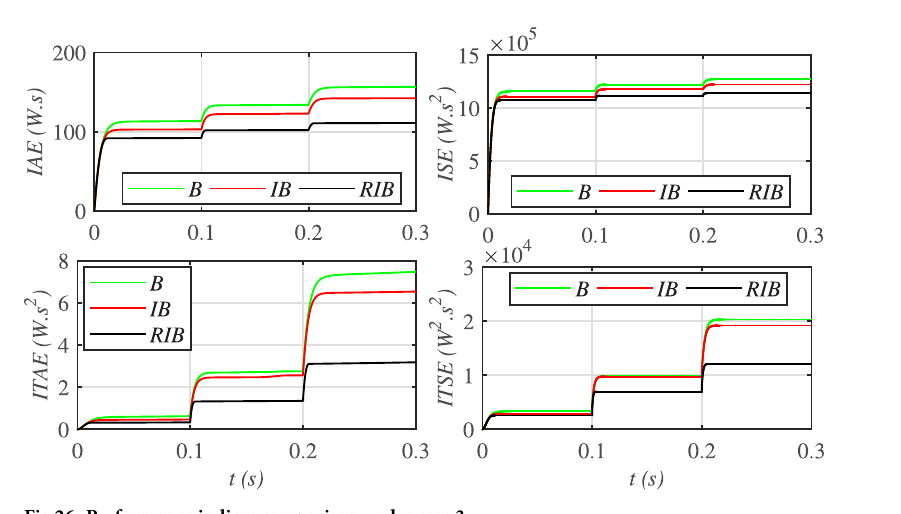
Fig 26. Performance indices comparison under case